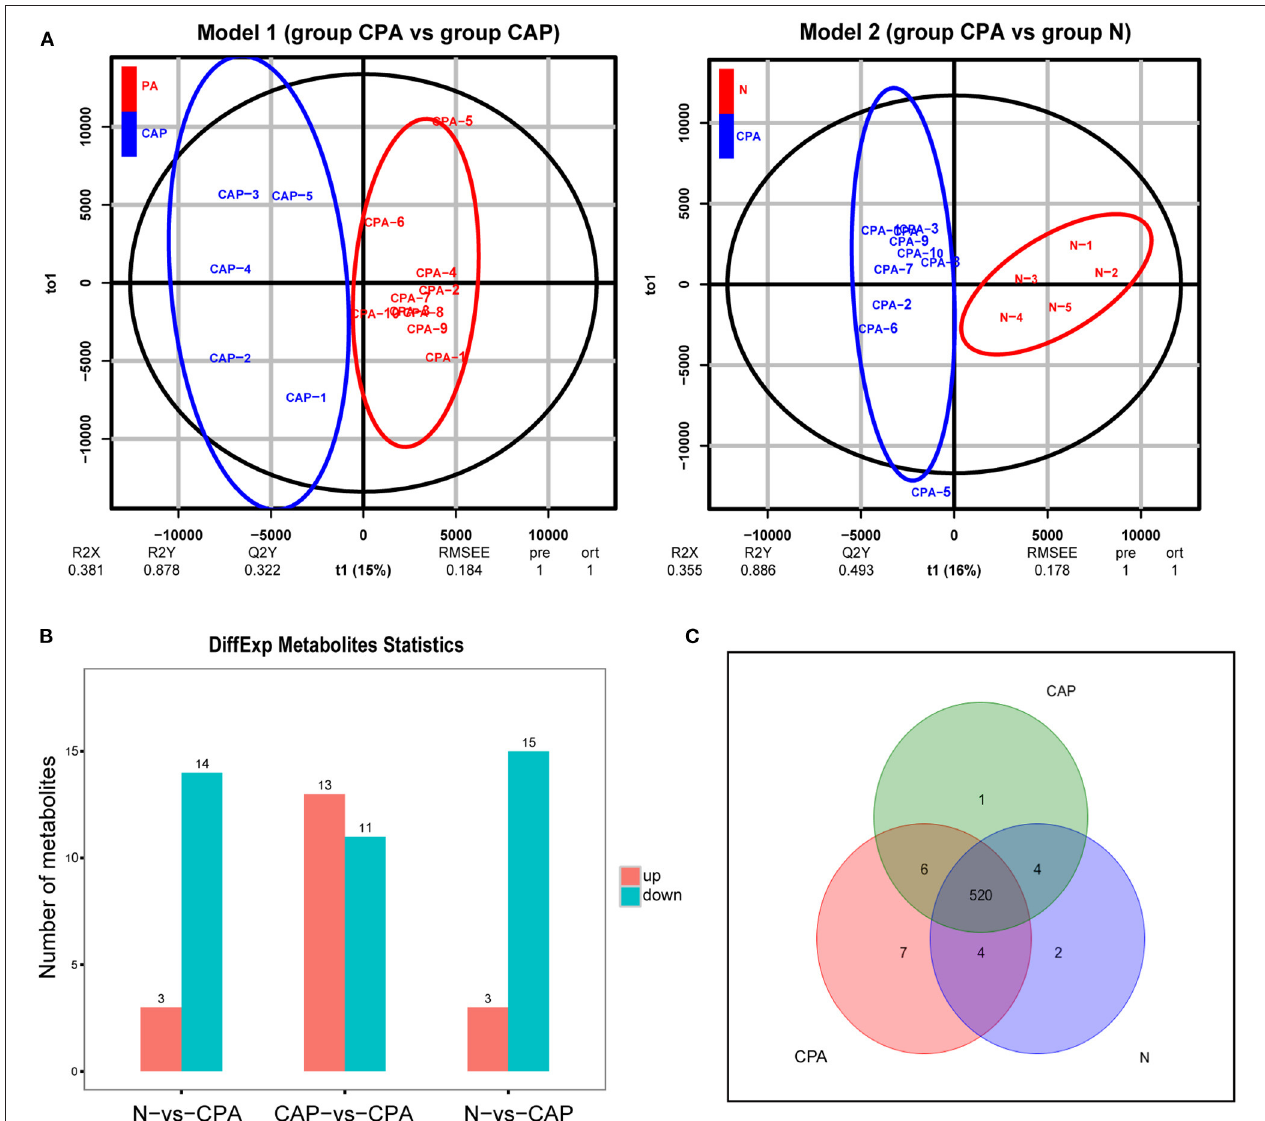
FIGURE 2 | Serum metabolome analysis for distinguishing group CPA from group CAP and group N. (A) OPLS-DA score plot of serum characteristic metabolites between the CPA group and the CAP and N groups. (B) Quantity change of different serum metabolites among group CPA, group CAP and group N. (C) Venn analysis of serum characteristic metabolites in patients with